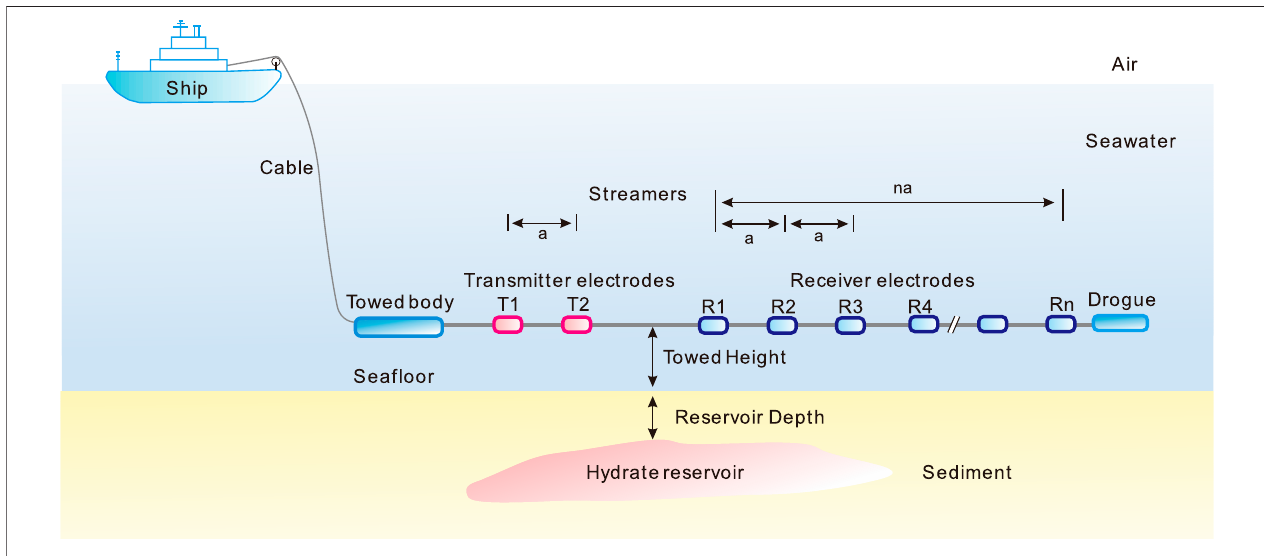
FIGURE1| Con fi gurationofmarinetowedelectricalresistivitysystemwithmulti-componentstreamersDCRarrayarrangement.Theshiptowedalongcableclose to thesea fl oortodetect structures beneath thesea fl oor. TheDCR arrayarrangementiscomposed ofmultiple receiver electrodes alongwithtransmitterelectrodes,and the number of the receiver electrodes is more than that of the transmitter electrodes. The effect of exploration can be perfected by increasing the quantity of the receiver electrodes in the DCR array arrangement.